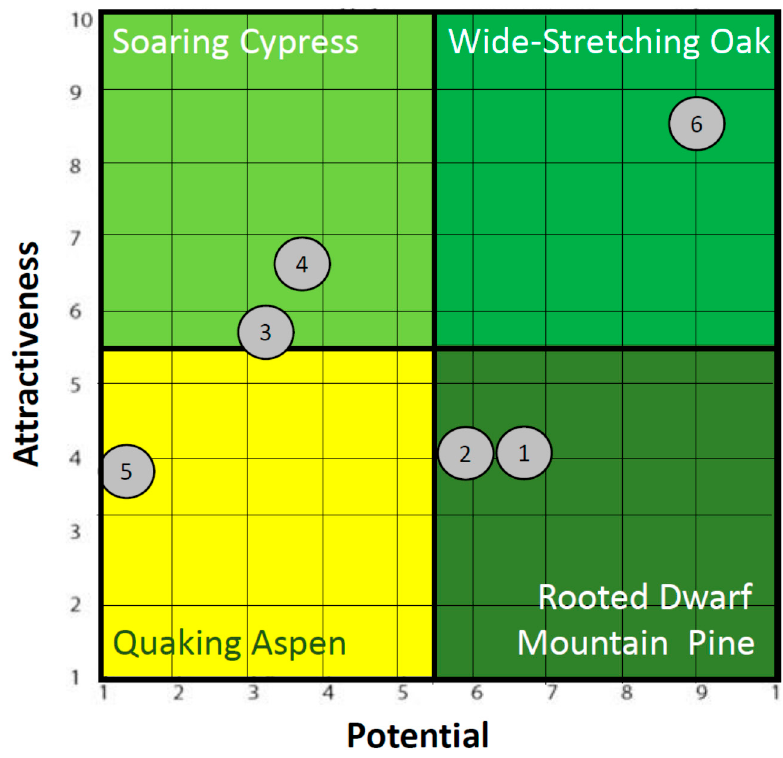
Figure 11. Dendrological matrix of methods of protection against the effects of SARS-CoV-2 coronavirus.